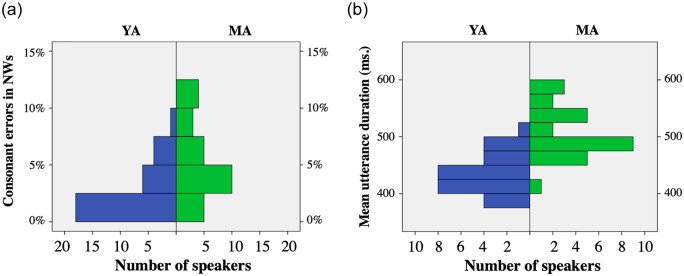
Corpus descriptors: ratio of consonant errors annotated by phoneticians (a) and utterance duration (b).